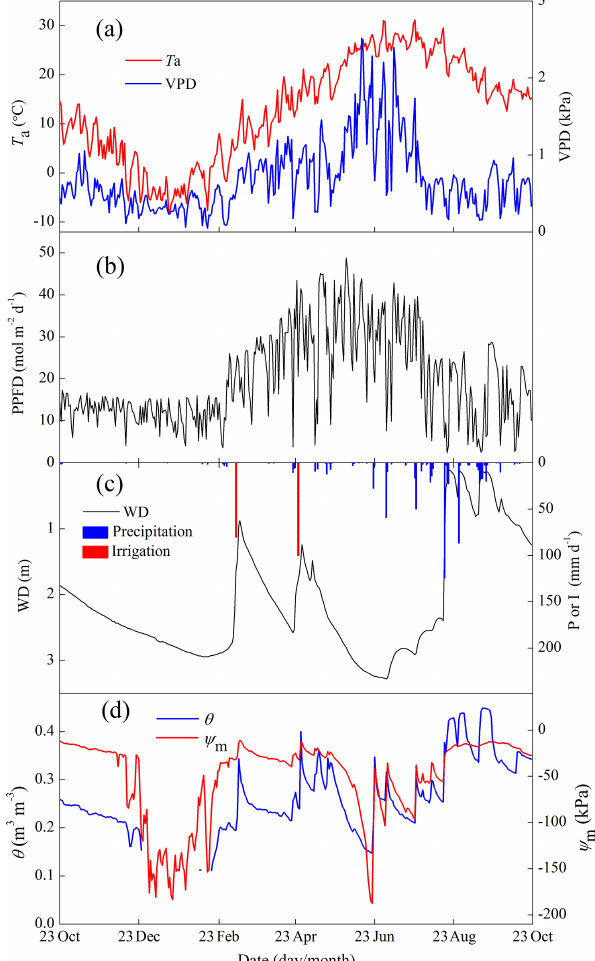
(a) air temperature ( T a ) and vapor pressure deficit (VPD); (b) pho- tosynthetic photon flux density (PPFD); (c) precipitation ( P ), irri- gation ( I ), and groundwater depth (WD); and (d) volumetric soil moisture ( θ ) and soil matric potential ( ψ m